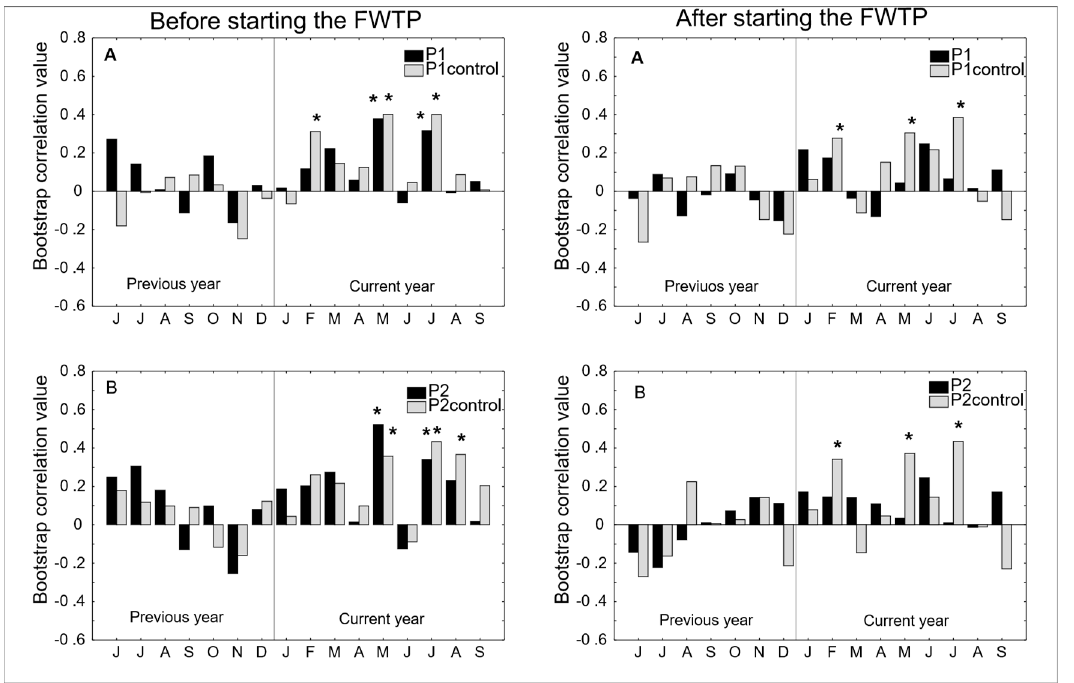
Figure 9. Relationships between precipitation and radial growth (TRW) of Scots pine growing on the study plots (residual chronologies) for the period before fertiliser application and the period after starting operation of the Forest Wastewater Treatment Plant). ( A )–plots with younger trees; ( B )–plots with older trees. Asterisks (*) indicate significance at p < 0.05.